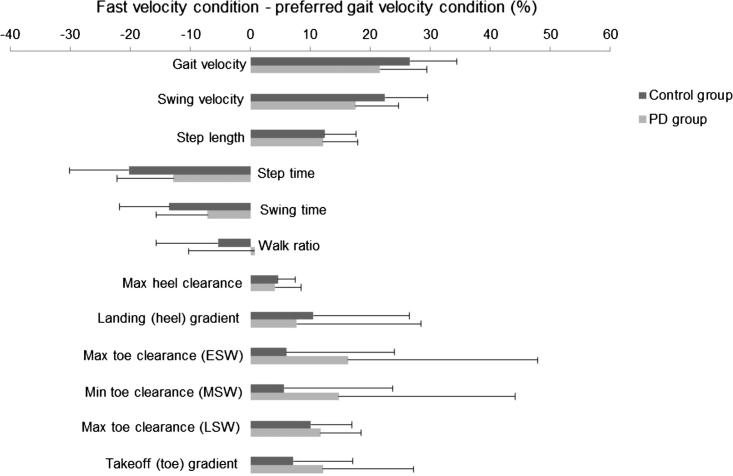
Relative difference (%) in temporal-spatial components of gait and foot clearance parameters with error bars indicating group standard deviation. ESW, MSW and LSW denote early, mid- and late swing, respectively.